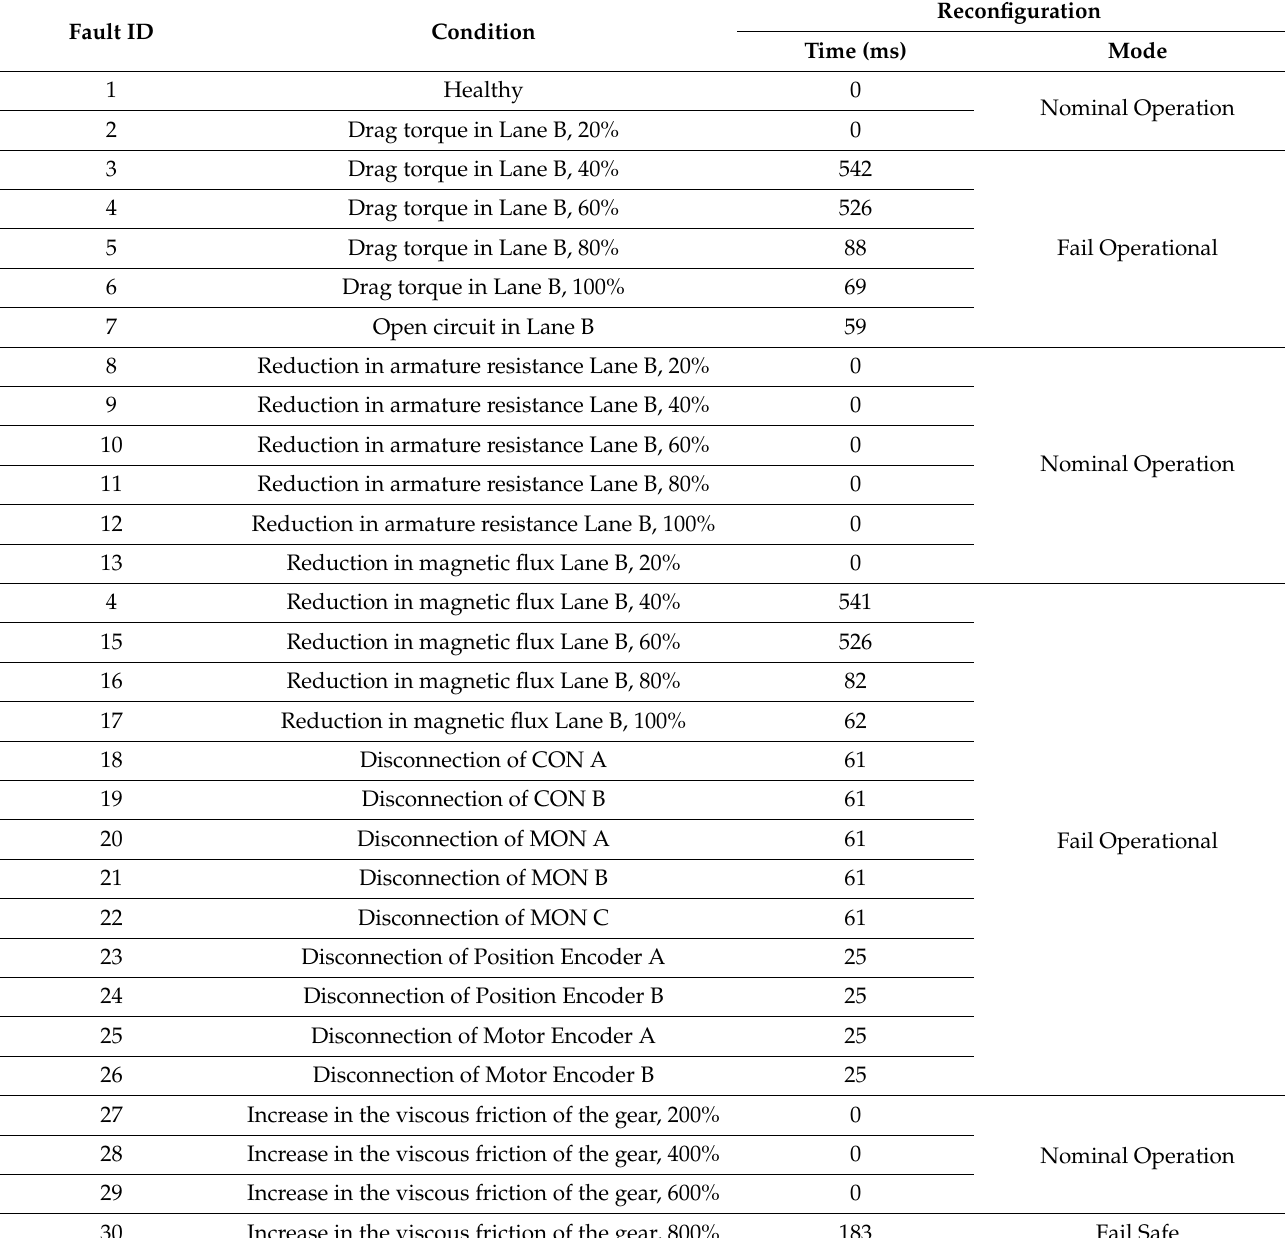
Table 12. Fault detection and reconfiguration for 30 health